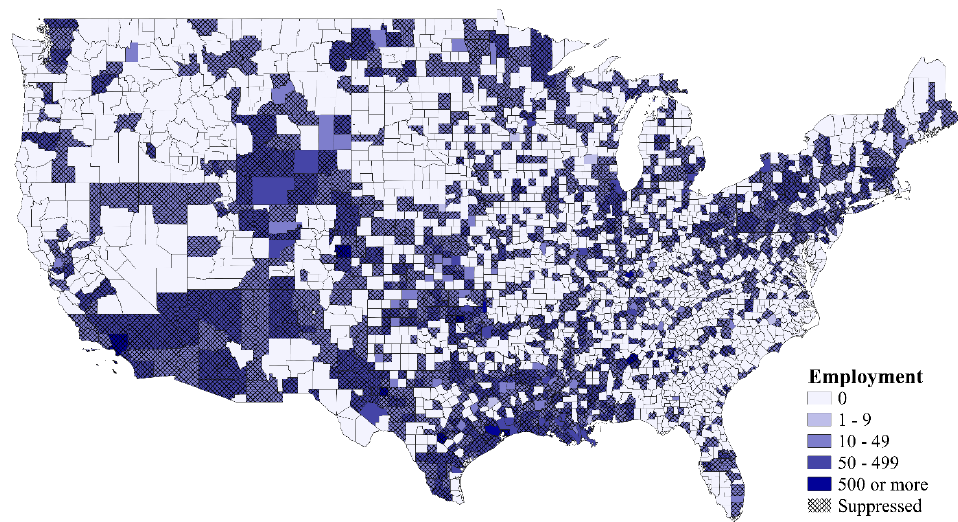
Figure 1: Employment Distribution of Pipeline Transportation (NAICS